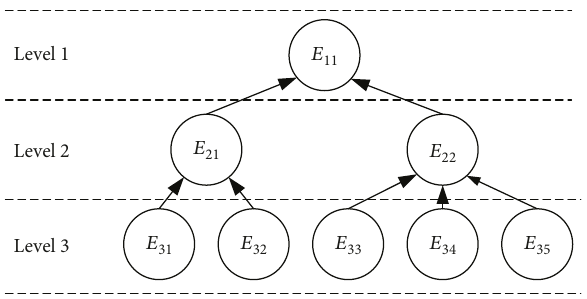
Figure 5: BN representation of the HGD system with three types of reliability test